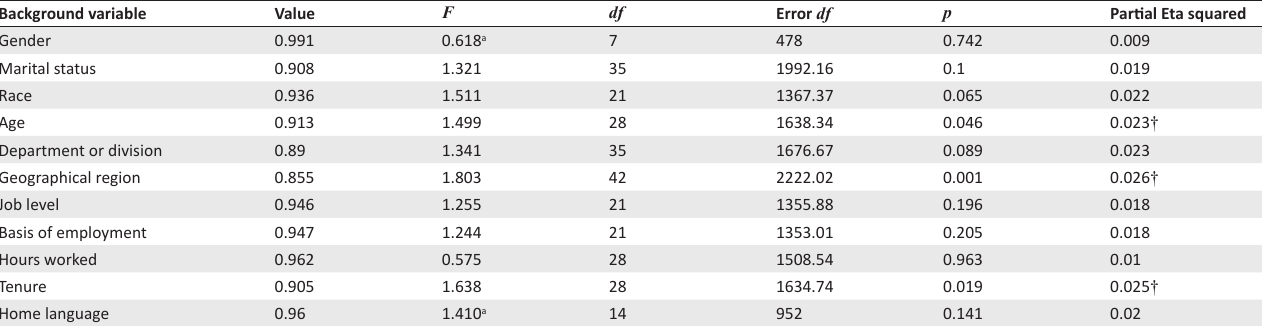
TABLE 4: MANOVAs – Wilks’ Lambda demographic variables and the EnergyScapes Profile dimensions. Background variable